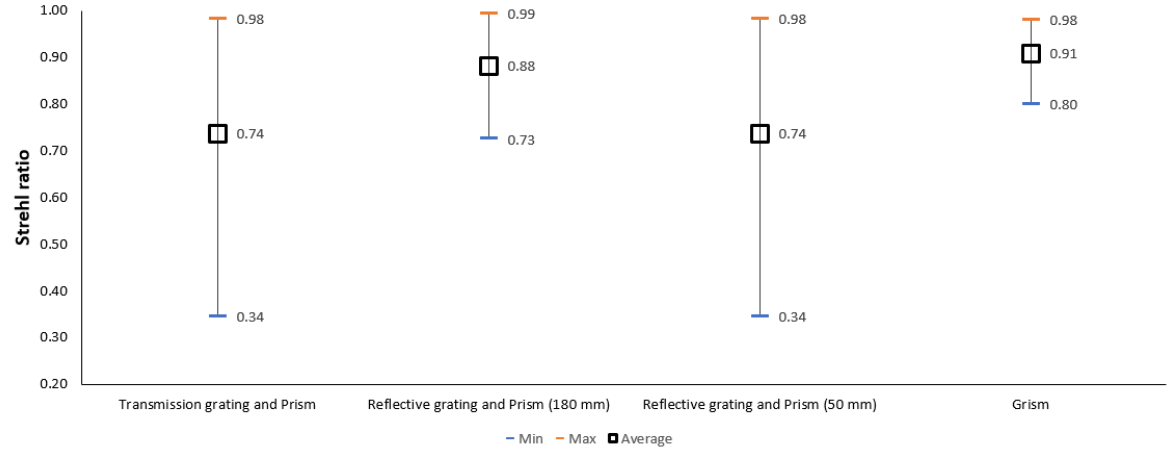
Figure 14. Strehl ratio of different